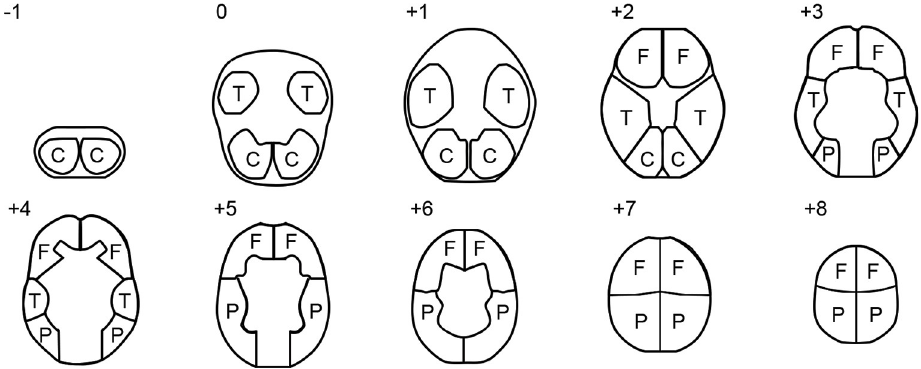
Fig 1. Regions-of-interest. An overview of the regions-of-interest (ROIs) used in the current study. Numbers refer to centimeters above/below the orbitomeatal line. C = cerebellum, T = temporal lobe, F = frontal lobe, P = parietal